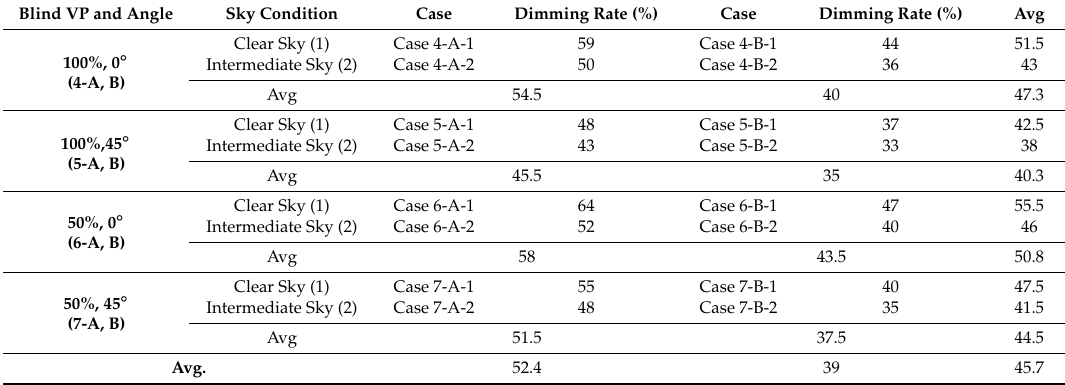
Table 9. Dimming rate for sky conditions under manual blind